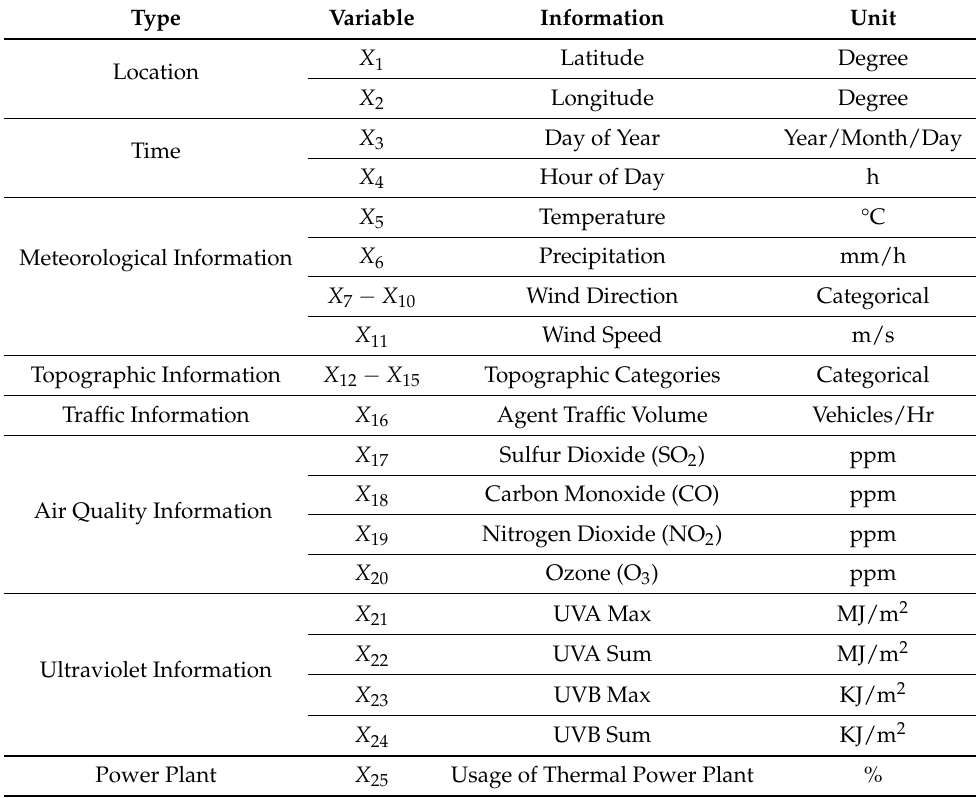
Table 2. Variable information.